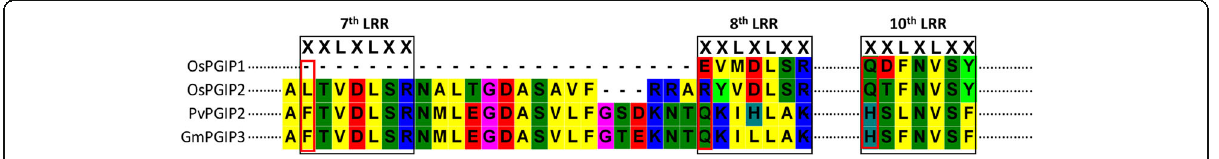
Fig. 3 Alignment of OsPGIP1, OsPGIP2, PvPGIP2 and GmPGIP3 amino acid sequences. LRR motifs associated with extracellular or extracytoplasmic location are indicated by the consensus XXLXLXX motifs. The amino acids in OsPGIP2 that differ from the corresponding residues in OsPGIP1, PvPGIP2 and GmPGIP3 are bordered with red rectangles. Dashed ( − ) lines represent gaps in OsPGIP1 and OsPGIP2; dotted lines represent the omitted amino acids in all four